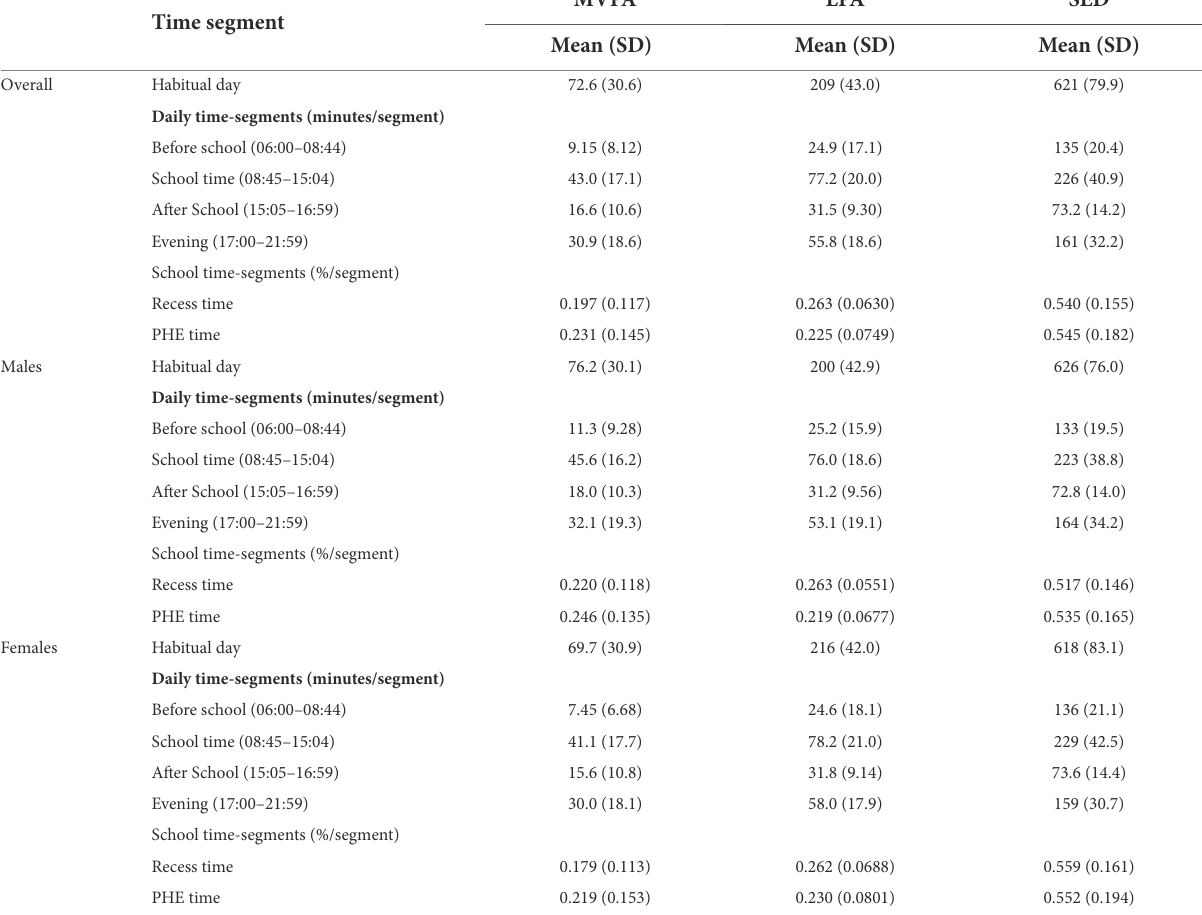
TABLE 2 Participant’s daily and time-segmented levels of SED, LPA, and MVPA ( n = 161).